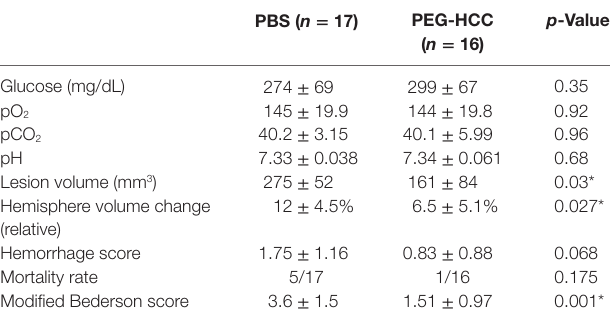
TaBle 1 | Results of hydrophilic carbon cluster, conjugated to poly(ethylene glycol) (PEG-HCC) treatment compared with controls in hyperglycemia after 90 min occlusion and assessment at the end of experimental